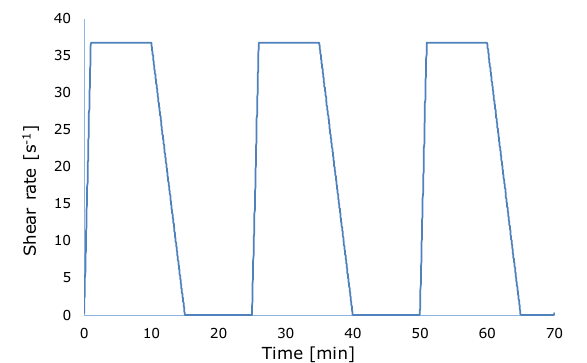
Figure 2. Experimental setup for the investigations with the double gap basket cell.